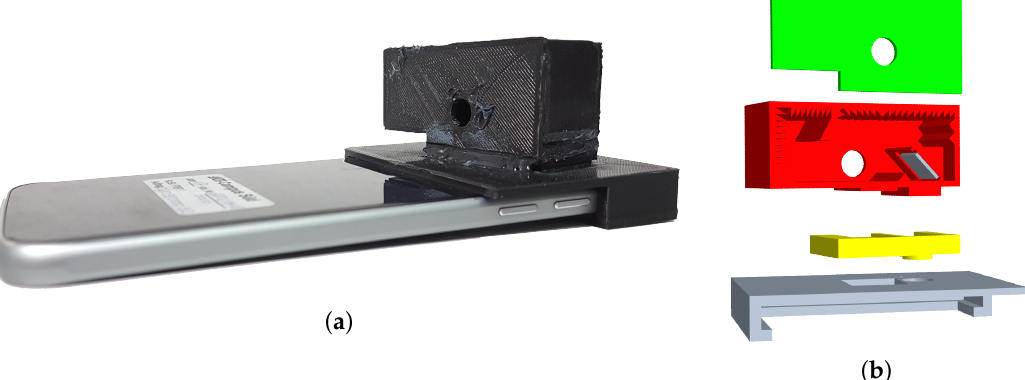
Figure 4. ( a ) Galaxy S6 phone with FeinPhone sensor prototype. ( b ) The clip-on modules were 3D printed for rapid